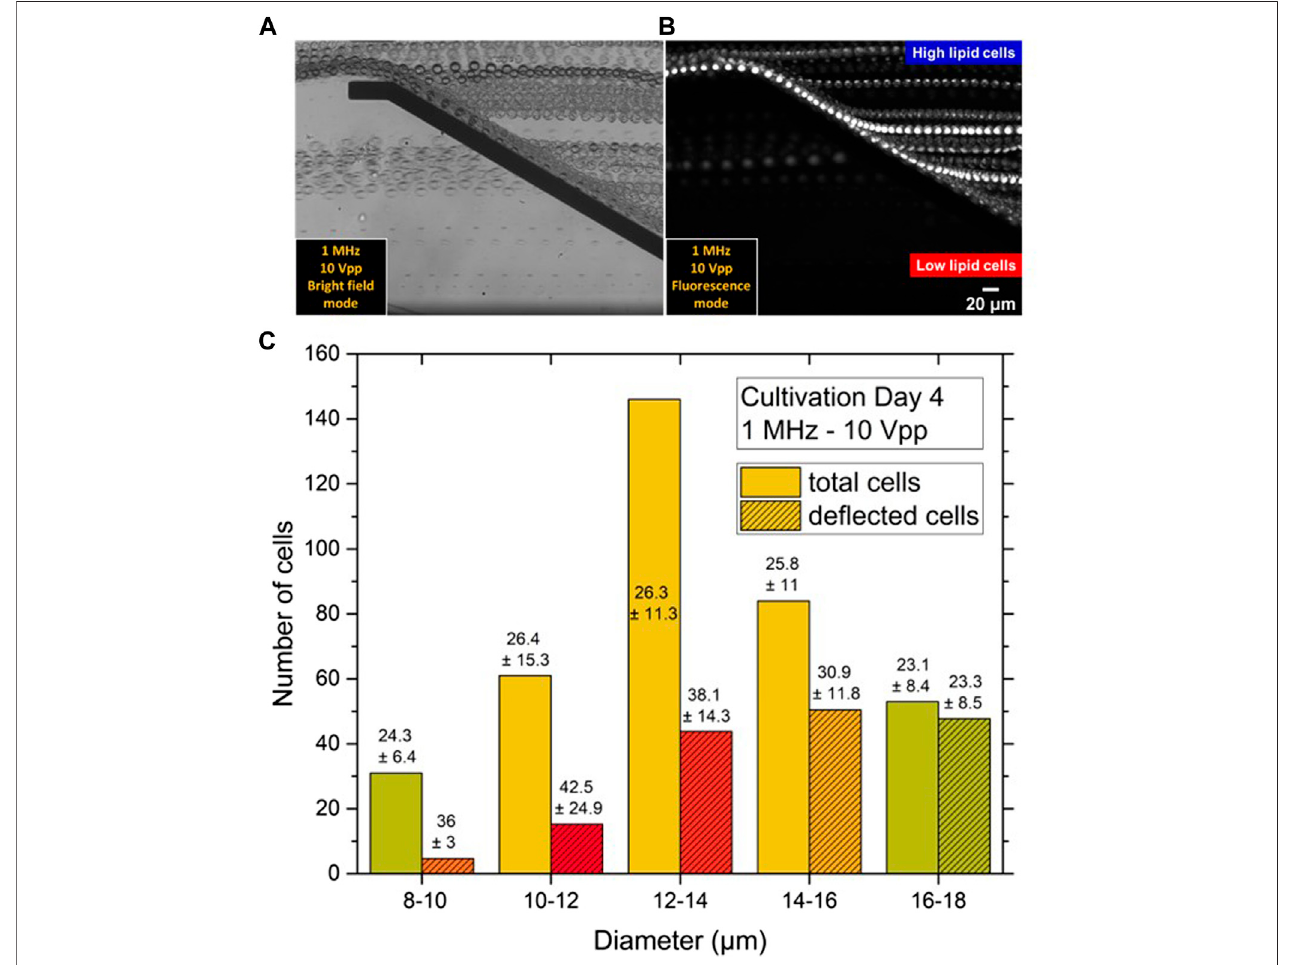
FIGURE 10 | (A) t stack images of bright fi eld and (B) fl uorescence micrographs showing the nDEP effect for C. cohnii microalgae at 1 MHz and 10 V pp . The directionof fl owisfromrighttoleft.CellsofhighlipidcontentasaffectedbynDEParerepelledbythetop-bottomelectrodestructure,separatingthemfromlowlipidcells, which are fl owing between the electrode pair without altering their direction of fl ow. (C) Size distribution of cell suspension at day 4 of cultivation before and after DEP separation. Numbers stand for the mean lipid content ϕ L of each size class and its dispersion δϕ L . Unstriped bars show the initial number of cells N i before DEP separation, which compares to Day 4 slices in Figures 3 , 9 . Striped bars stand for the number of cells as observed after DEP separation in the de fl ected fl ow. Inscribed data now indicate average ϕ L values as determined from the high-lipid fraction of each size class, the percentage of which was derived from 10 V pp values in Figure 8 . The lipid content ϕ L of de fl ected cells is seen to surmount that of unde fl ected ones for all size classes, except for the last